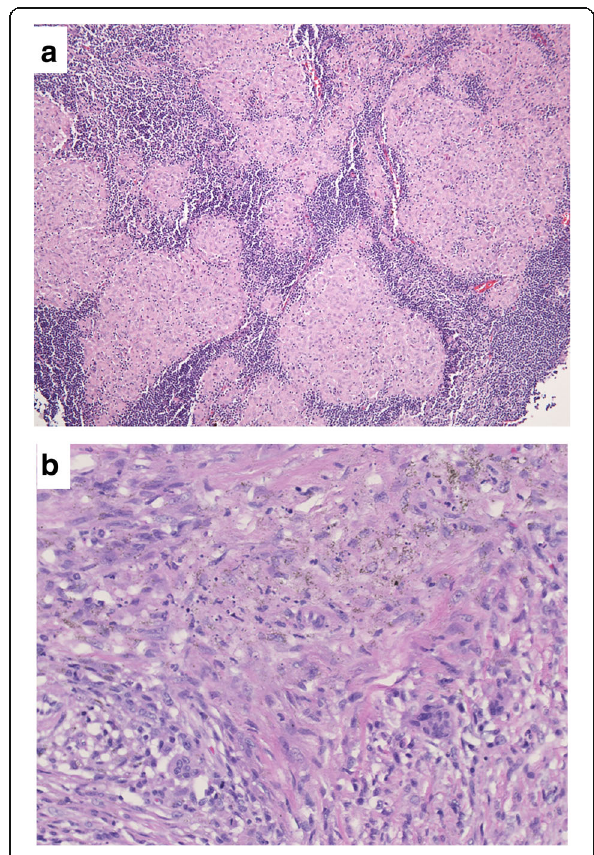
Fig. 2 Histology of lymph nodes resected from case 1. A photomicrograph of the specimens shows granulomatous reactions, histiocytes, multinucleated giant cells, and scar-like fibrosis without malignant cells ( a magnification × 100, b × 400, Hematoxylin and Eosin staining) lesion (SUV max: 23.1) and lymph nodes (SUV max: 5.45) from the cervical to upper mediastinal region (Fig. 3). However, it was difficult to determine whether the multiple lymphadenopathy was benign or metastatic because of her past medical history of sarcoidosis.